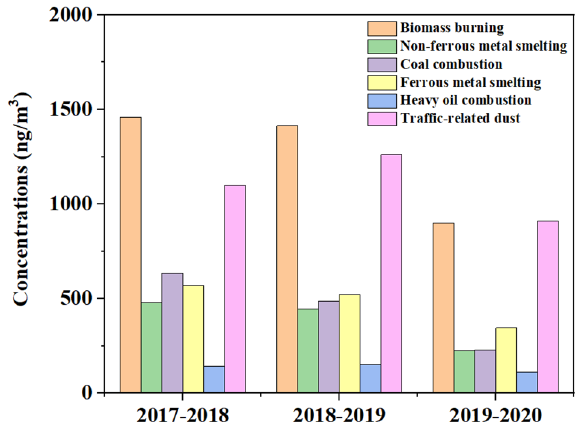
Figure 7. Deweathered mean concentrations of trace elements de- rived from six sources in Tangshan during